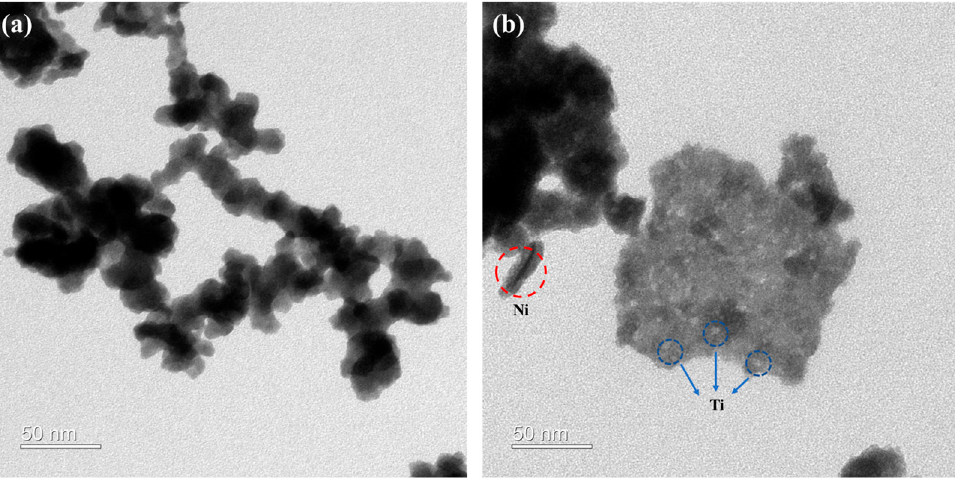
Figure 3. TEM images of ( a ) Bi 2 WO 6 and ( b ) 0.4Ni/Ti-Bi 2 WO 6 .